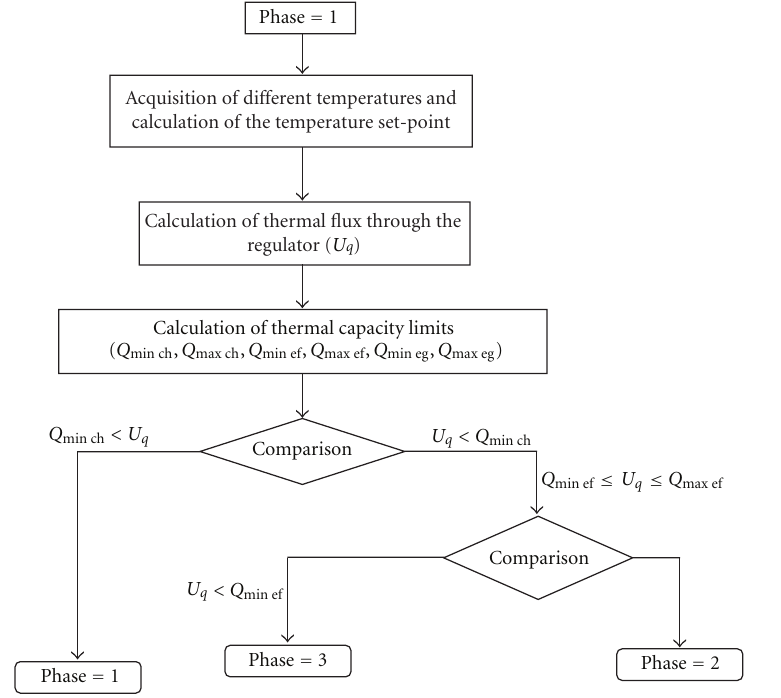
Figure 4: Flow chart of the supervisory and control in the case of the electrical resistance.